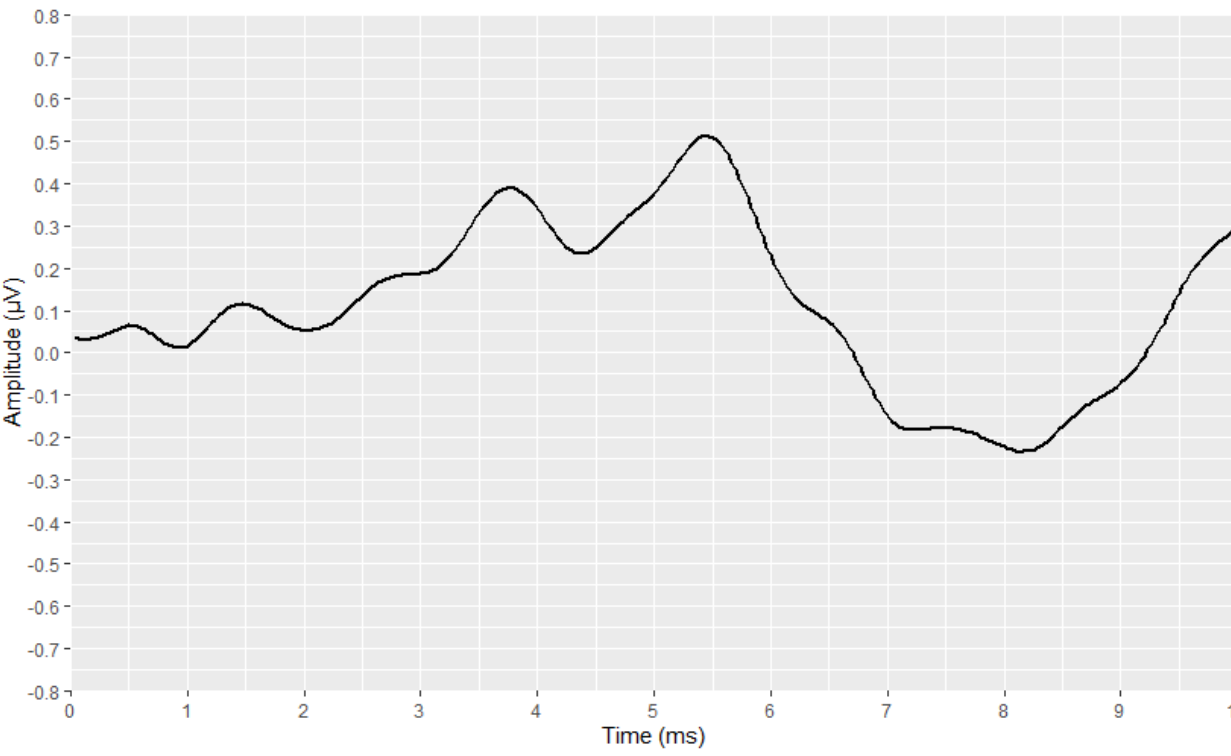
Figure 5. Visualization of an AMLR waveform after applying the visual display filters (raw signal is depicted in black and filtered signal is depicted in dark red).